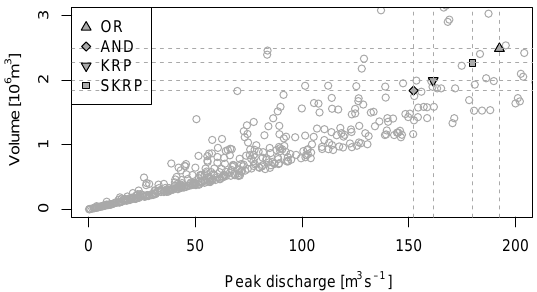
Figure 1. Comparison of different MRP definitions for a return pe- riod of 10 years (compare Figure 6 in Gräler et al.,